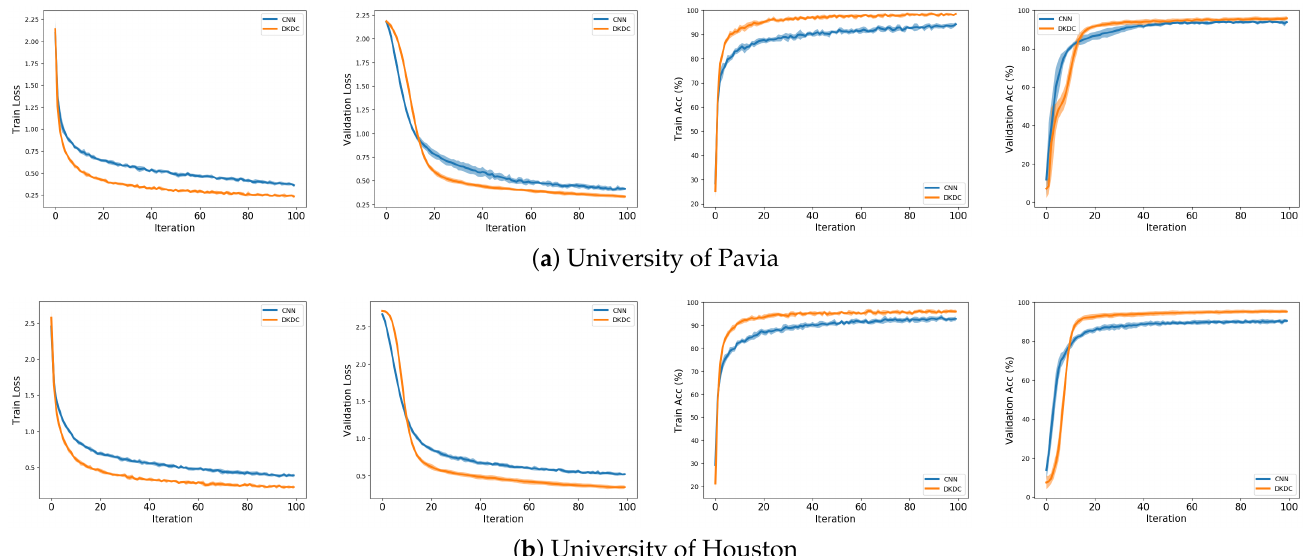
Figure 7. From left to right: training loss, validation loss, training accuracy, and validation accuracy. First row: obtained results with University of Pavia dataset. Second row: obtained results with University of